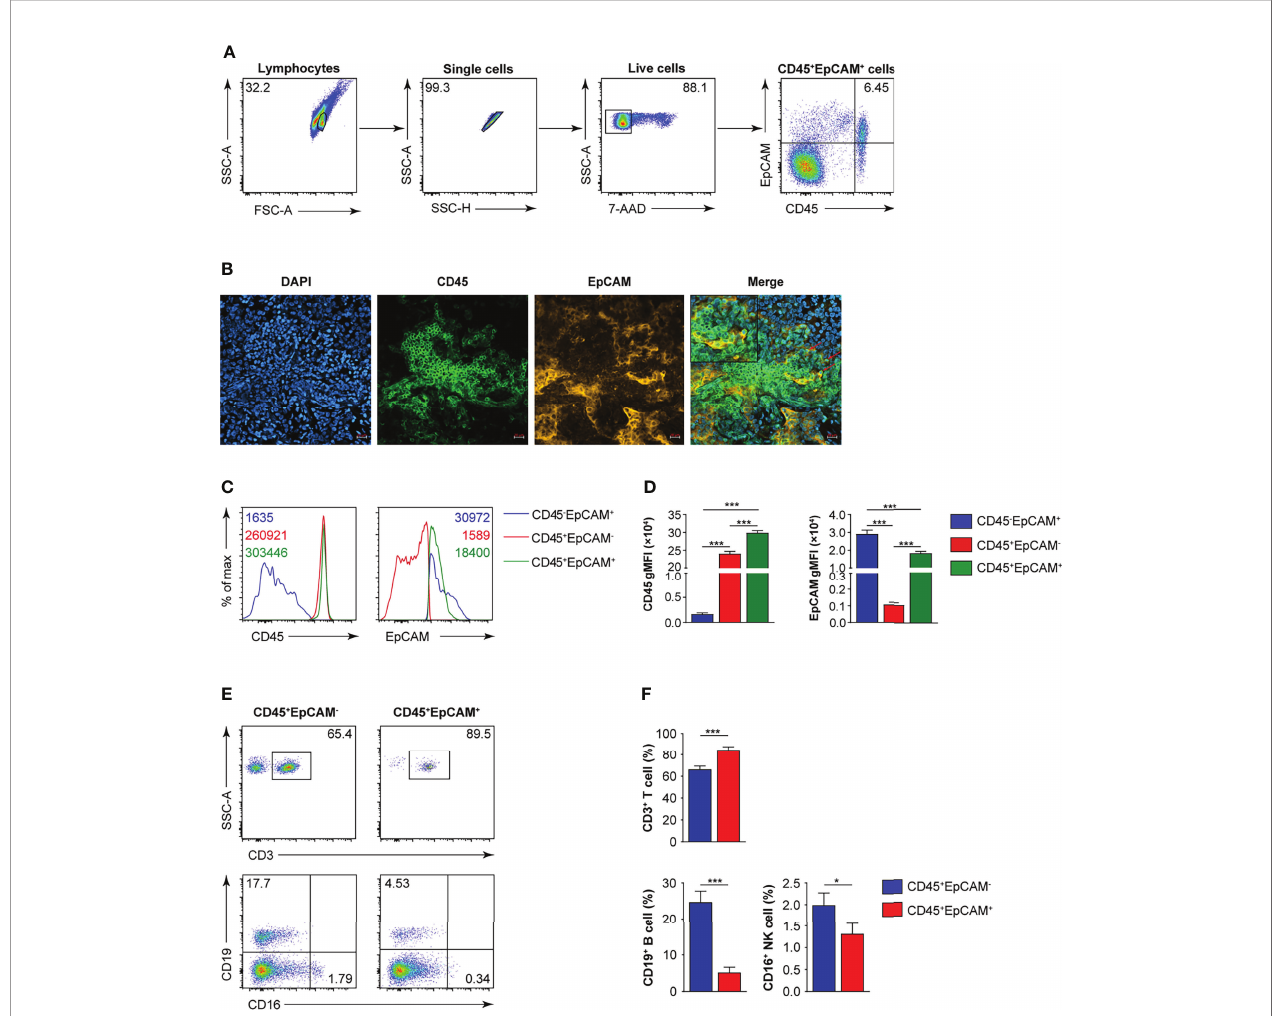
FIGURE 1 | CD45 + EpCAM + cells are detected in lung cancer tissue by FACS and immune- fl uorescence microscopy. (A) Flow cytometry analysis of CD45 + EpCAM + cells gated on live cells from solid tumors of patients with lung cancer with representative pseudocolor plot, respectively (average of CD45 + EpCAM + in lung cancer is 6.25%, n = 25). (B) Confocal microscopy analysis of CD45 + EpCAM + cells in solid tumors from patients with lung cancer. Green: CD45, red: EpCAM. Scale bar: 20 m m. Representative fi gures are presented from two independent experiments. (C, D) Expression of CD45 and EpCAM on CD45 + EpCAM + cells was analyzed using fl ow cytometry with typical histograms and quanti fi cation data in (C, D) , respectively ( n = 25). (E, F) Flow cytometry analysis of CD3 + T, CD19 + B, and CD16 + cells gated on CD45 + EpCAM + cells or CD45 + EpCAM − cells from tumors of patients with lung cancer with typical pseudocolor plots and cumulative data in (E, F) , respectively ( n = 25). Data are representative of 25 separate experiments. Error bars represent SEM. * P < 0.05, and *** P < 0.001 (Student ’ s t